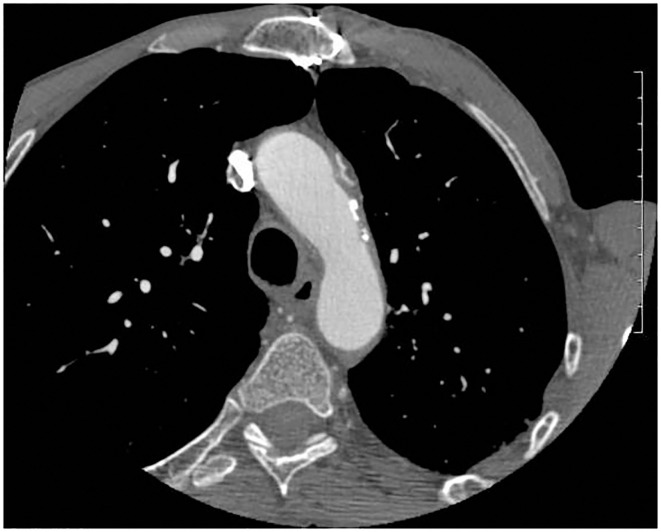
Computed tomography angiography showing an AAA.